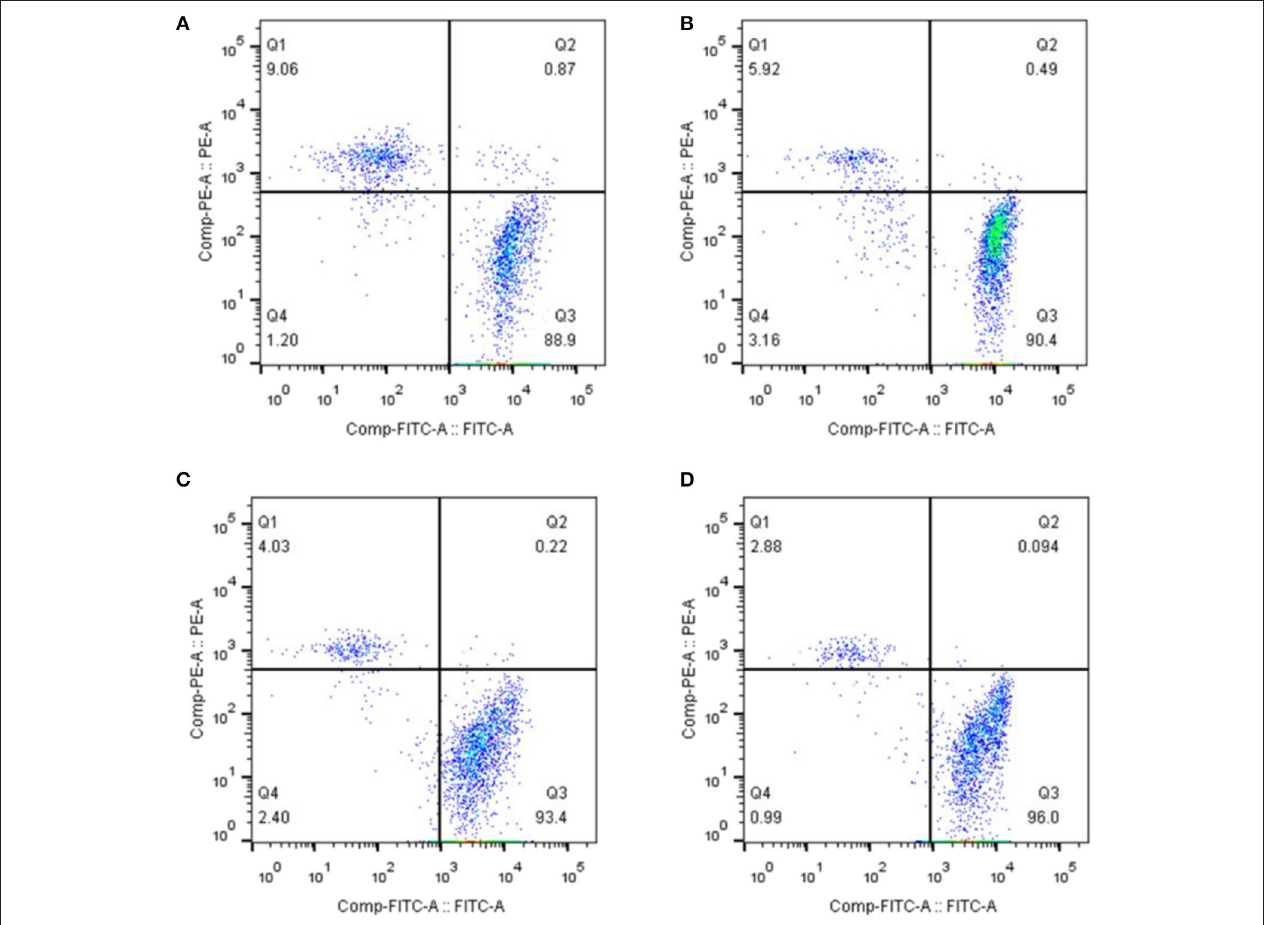
FIGURE 3 | Induction of cell death and membrane damage by CSFV infection of PBMCs depended on the activity of caspase 1. (A) Flow cytometry was used to determine the ratio of membrane damaged peripheral blood monocytes caused by CSFV infection. PBMCs were infected with CSFV at an MOI of 1 for 24h. (B) The proportion of dead PBMCs resulting from membrane damage induced by CSFV infection was affected by treatment with AC-yVAD-CHO. PBMCs were infected with CSFV at an MOI of 1 and transfected with 1 µ M AC-yVAD-CHO. (C) PBMCs were infected with CSFV at an MOI of 1 and transfected with 10 µ M AC-yVAD-CHO. The ratio of membrane damage cells was determined using Flow cytometry. (D) PBMCs were mock treated at